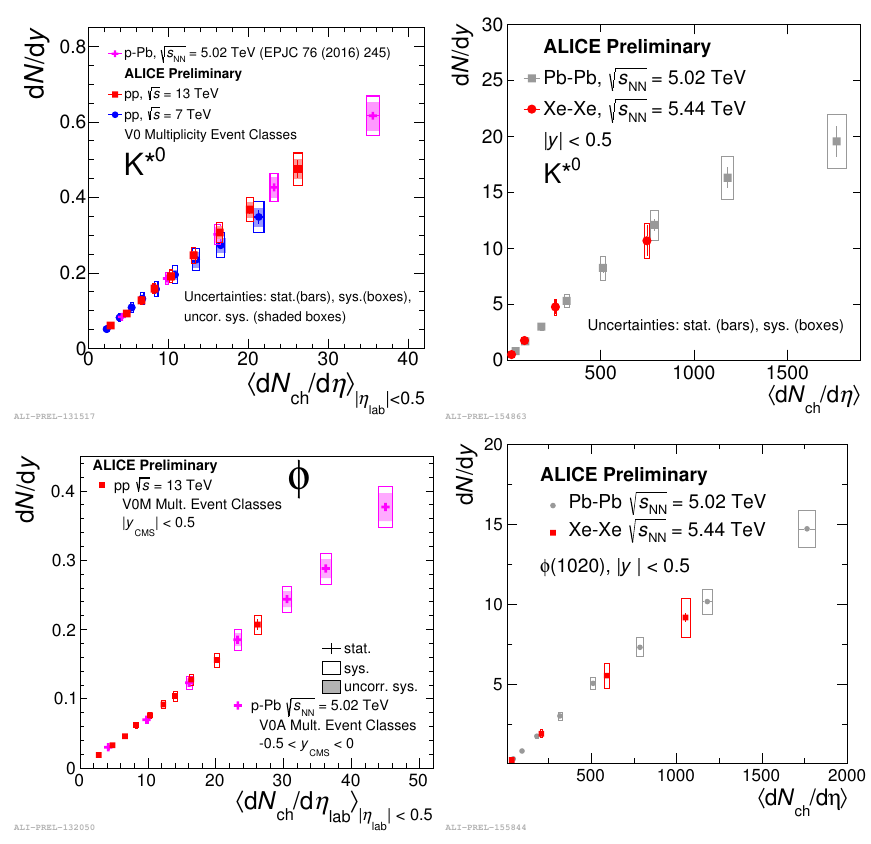
Figure 4. (color online) p T -integrated yields (dN / dy) of K ∗ 0 (top) and φ (bottom) as a function of the charged-particle multiplicity density in pp and p-Pb [4] (left) and Xe-Xe and Pb-Pb (right) collisions